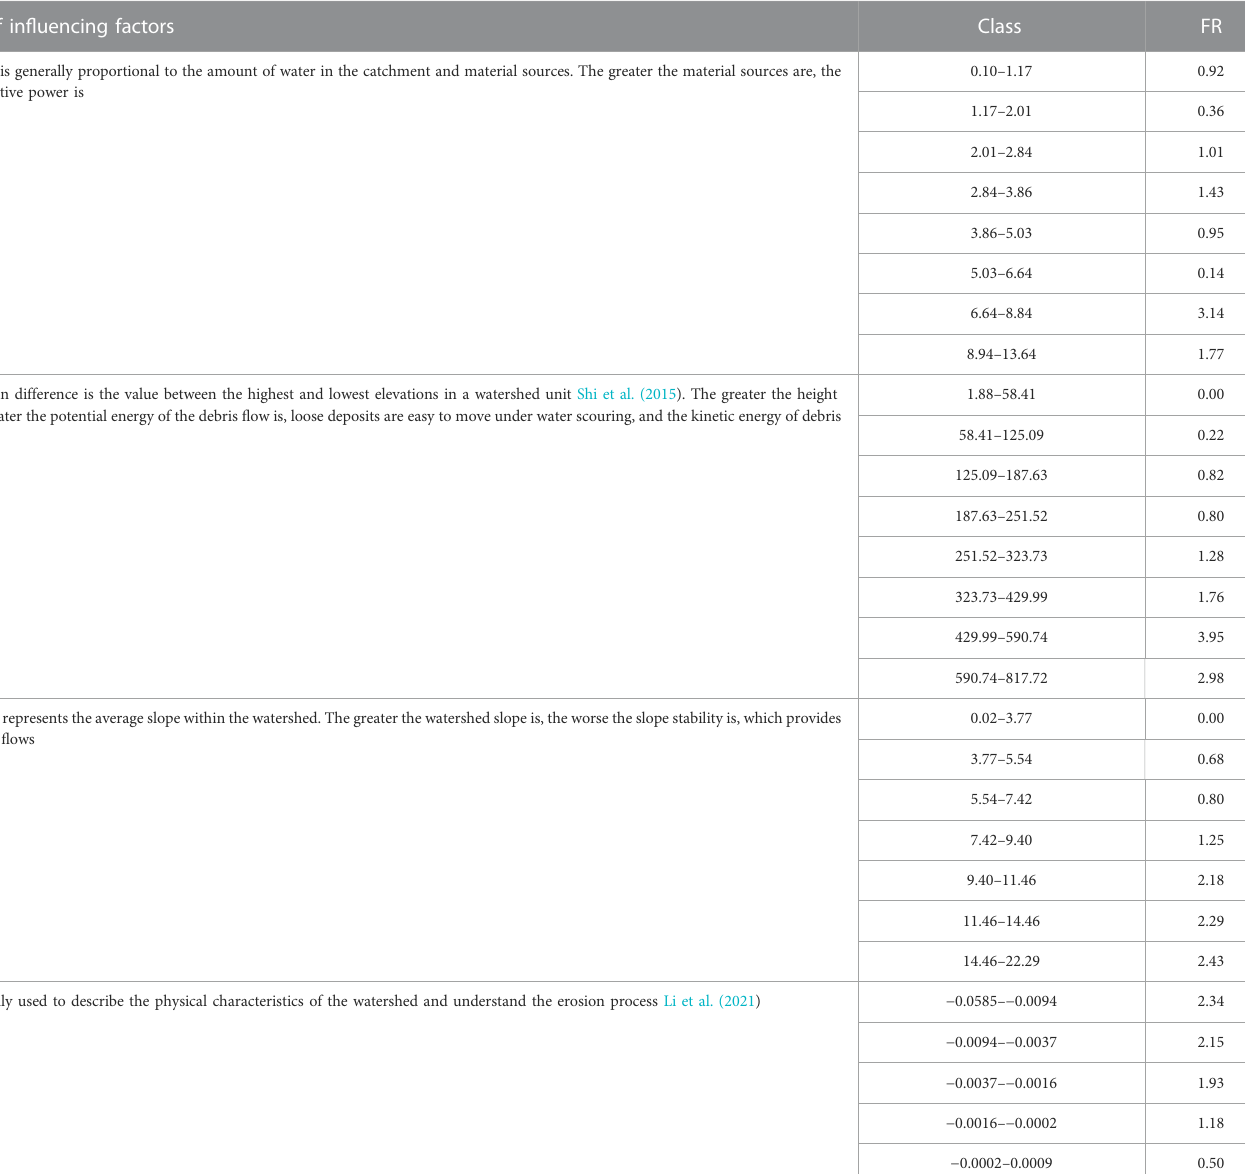
Curvature is generally used to describe the physical characteristics of the watershed and understand the erosion process Li et al.